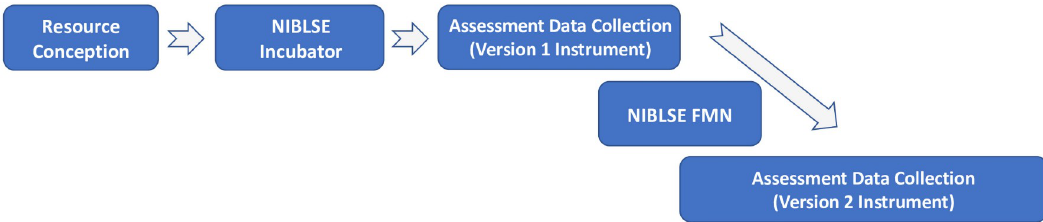
Fig 1. Development, implementation, and assessment of a NIBLSE OER learning resource. The original learning resource was conceived by a pair of institutional colleagues and implemented with course-specific student learning objectives. The resource was later expanded and targeted to a wider audience by a community of faculty through a NIBLSE Incubator. Following development of an assessment instrument, a NIBLSE Faculty Mentoring Network (FMN) recruited implementers and refined the assessment while collecting pilot assessment data. Data were collected from multiple institution and classroom settings concurrently during the FMN and after its conclusion. Vertically overlapping boxes indicate concurrent activities.